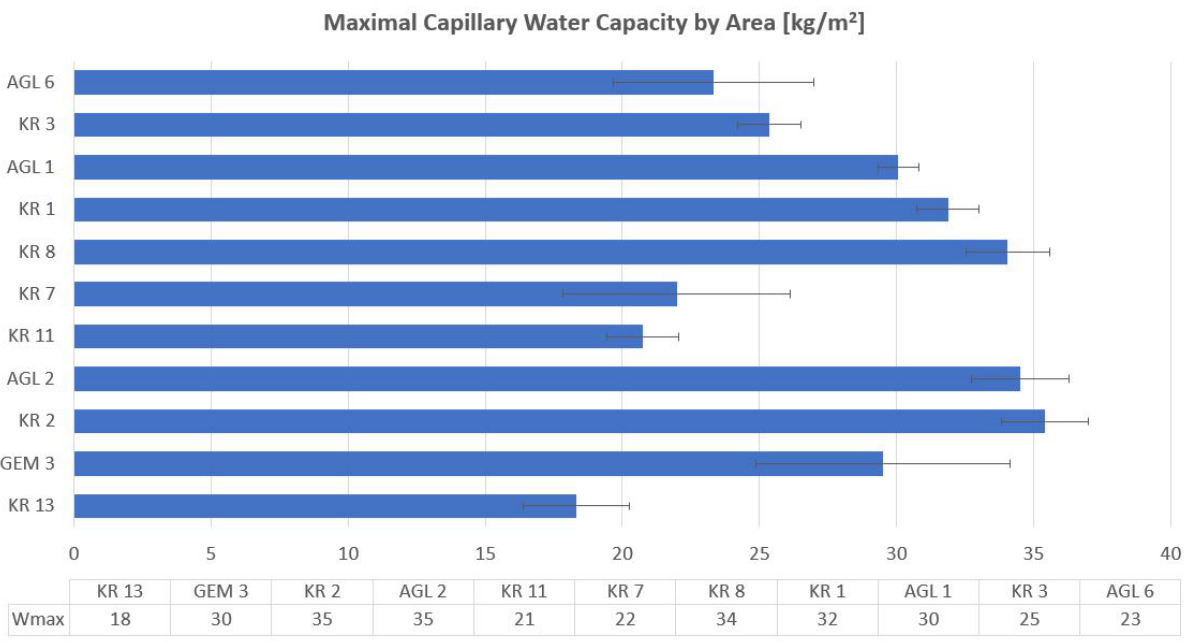
Figure 7. Maximal Capillary Water Capacity by Area.